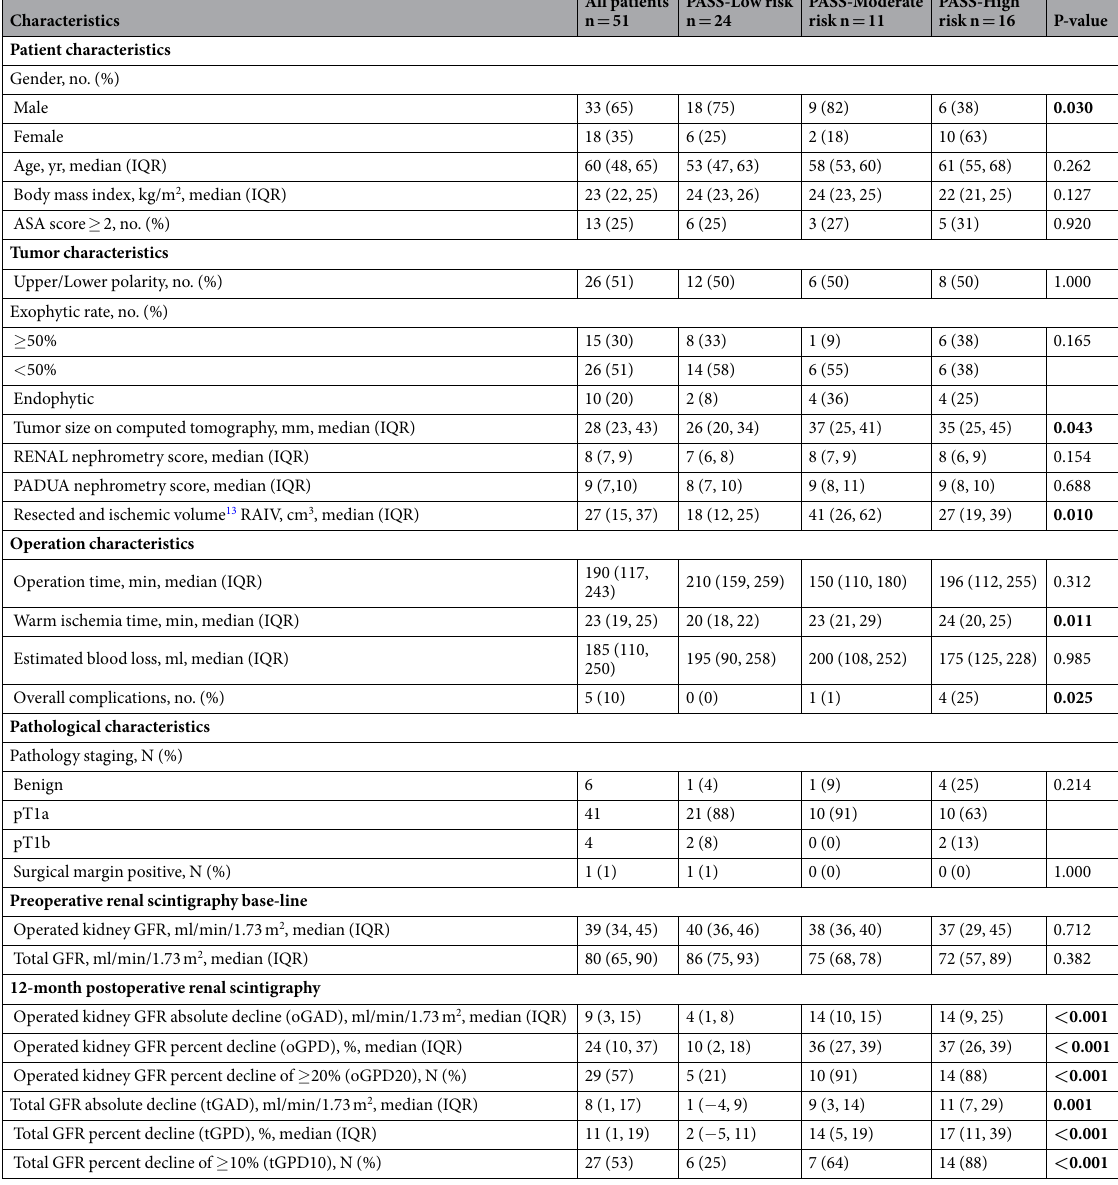
Table 2. Clinical variables and renal function outcomes of validation cohort. PASS = Peritumoral